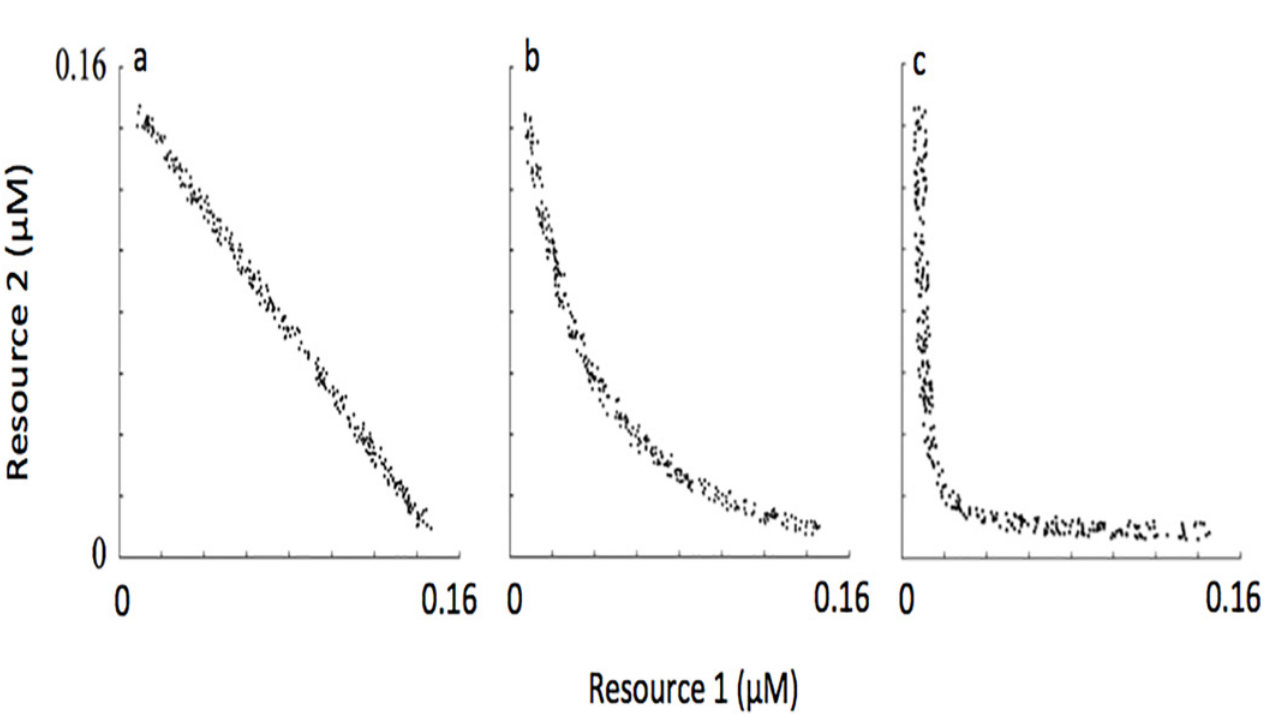
Fig 3. Representative R * species distributions in the initial pool of 300 populations at the lowest (a), intermediate (b) and highest (c) level of complementarity.